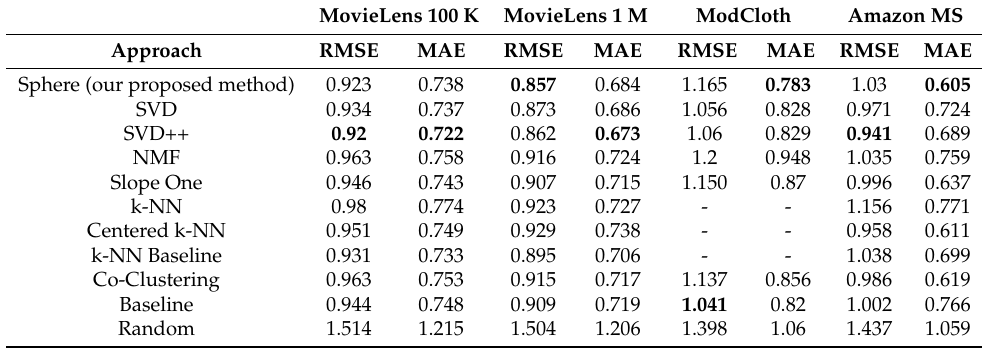
Table 2. Prediction Recommender Systems